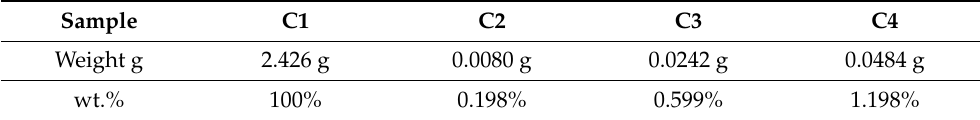
Table 1. Weight and weight percentages for various